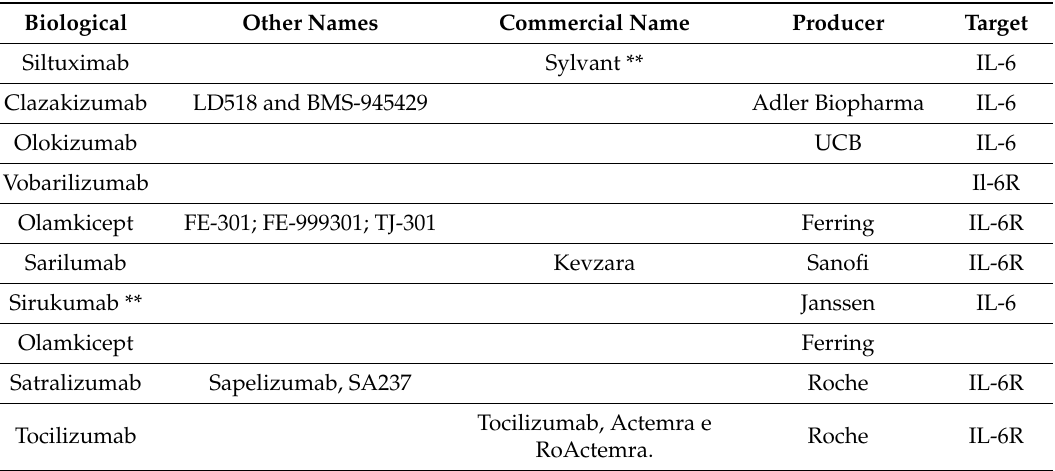
Table 1. IL-6 and IL-6R